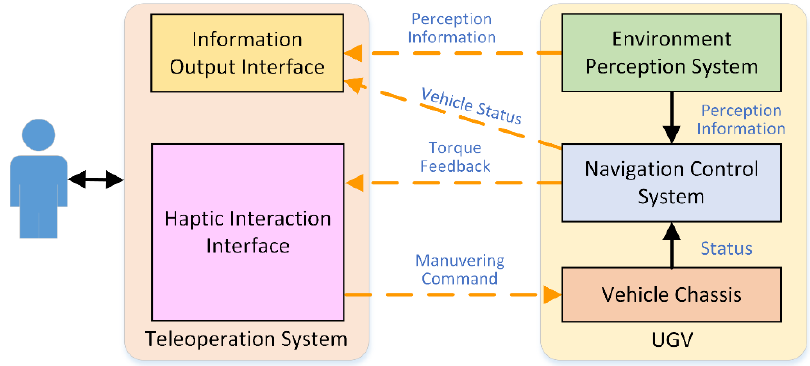
Figure 2. System overview of haptic interaction cooperative control.